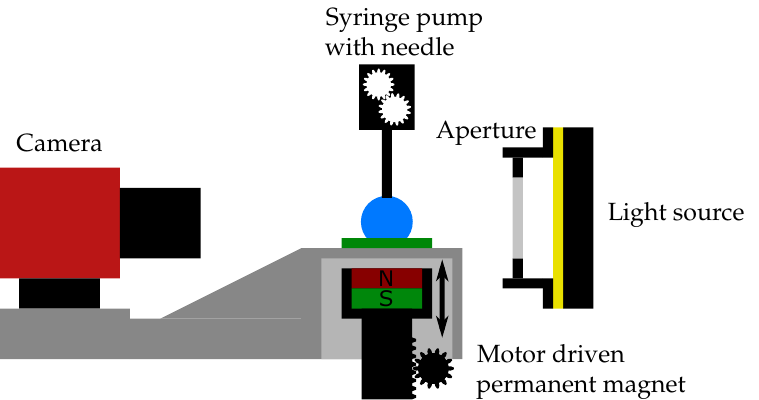
Figure 7. Experimental setup for contact angle measurements with a varying magnetic